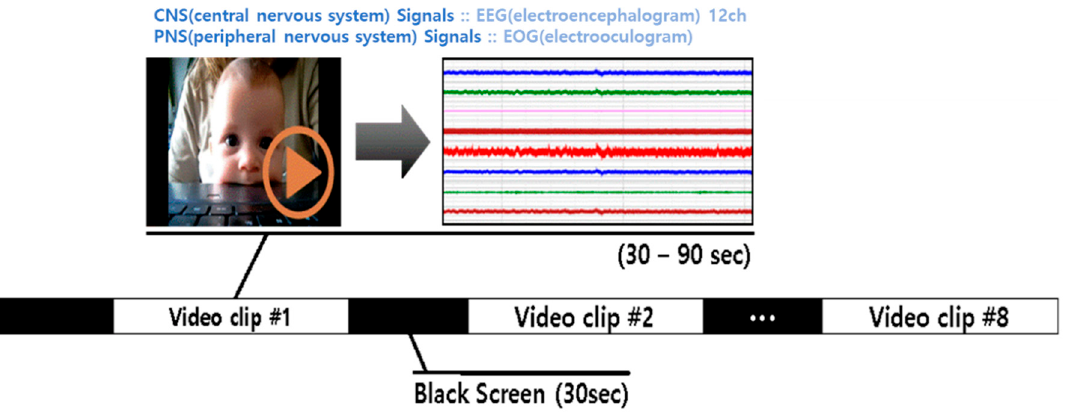
Figure 2. MERTI-Apps data collecting procedure.